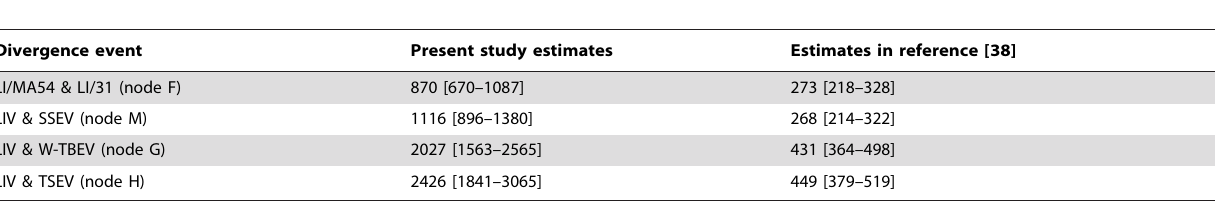
Table 5. Comparison of divergence times (in years before 2008) for main subtypes in the Tick-borne encephalitis virus species between the present study estimates and dating derived from rates of non-synonymous substitution calculated with a strict molecular clock [38].